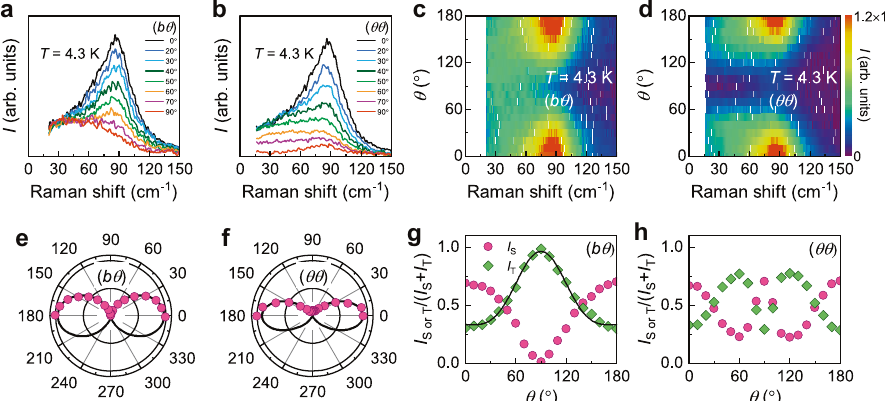
Fig. 2 Angular dependence of magnetic excitations in two polarizations. a , b Angular dependence of magnetic excitations measured at T = 4.3 K in ( b θ ) and ( θθ ) polarization con fi gurations. Phonon modes are subtracted to obtain the magnetic continuum. c , d Color plots of the magnetic Raman scattering intensity in the angle-Raman-shift plane in ( b θ ) and ( θθ ) polarizations. e , f Polar plots of the integrated intensity of a two-pair spinon – antispinon continuum. The solids lines are fi ts to a cos 2 θ dependence, obeying the A 1 symmetry. g , h Relative intensity of the triplon I T /( I S + I T ) and spinon I S /( I S + I T ) components as a function of angle. The solid line is modeled to a function of sin 4 θ + Rotational symmetry of spinon and triplon excitations . Having identi fi ed the two different elementary excitations, we discuss their rotational symmetry. Figure 2a, b and Supplementary Figs. 4 – 5 exhibit the angle-dependent variation of the magnetic Raman spectra at T = 4.3 K and T = 300 K. In the high- T hydrodynamic regime, we observe a quasielastic response origi- nating from spin and energy fl uctuations (Supplementary Note 6). In the low- T TLL regime, the quasielastic scattering evolves to the well-de fi ned spinon and triplon excitations as assigned above.